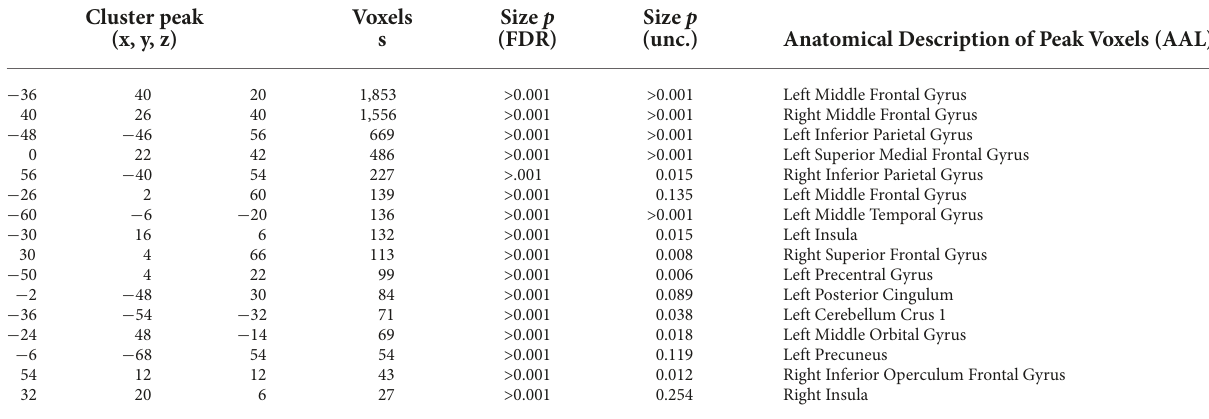
TABLE 1 lDLPFC to whole-brain results at